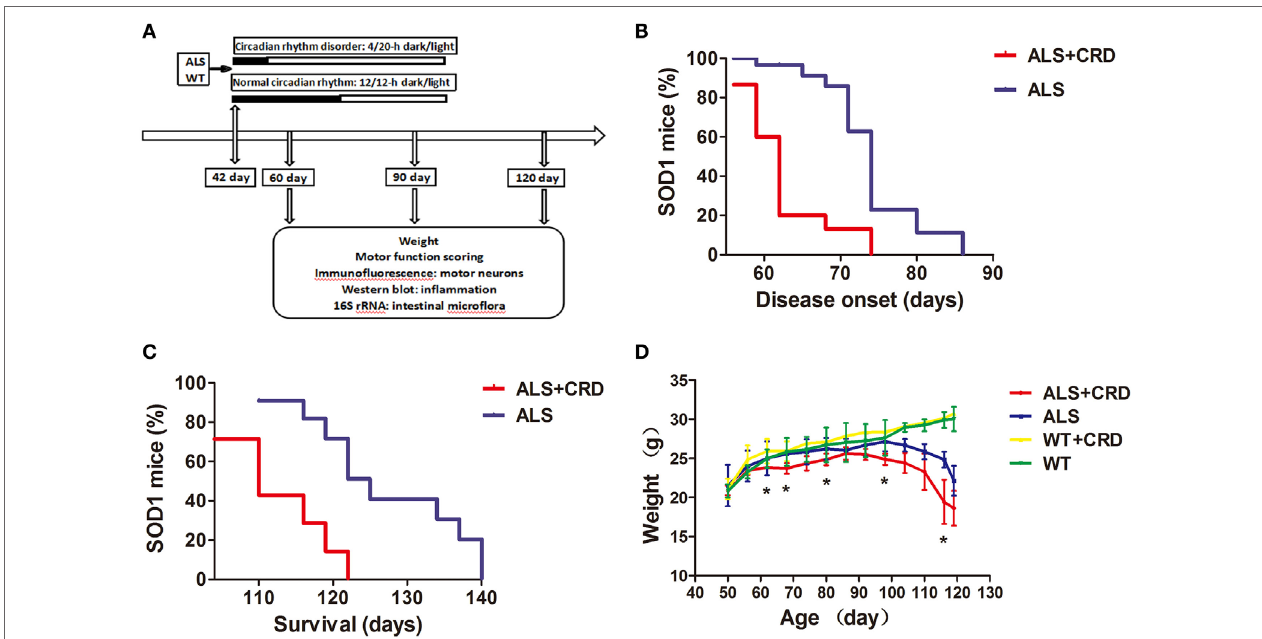
FigUre 1 | Circadian rhythm dysfunction (CRD) accelerated disease onset and progression in SOD1G93A mice. (a) A schematic showing the experimental procedures. (B,c) Survival curves: disease onsets and disease progression in the ALS + CRD and the ALS group. (D) Body weights loss of four groups starting from the day 50 to the day 119. N = 4–6 animals per group, * p < 0.05. Error bars represent